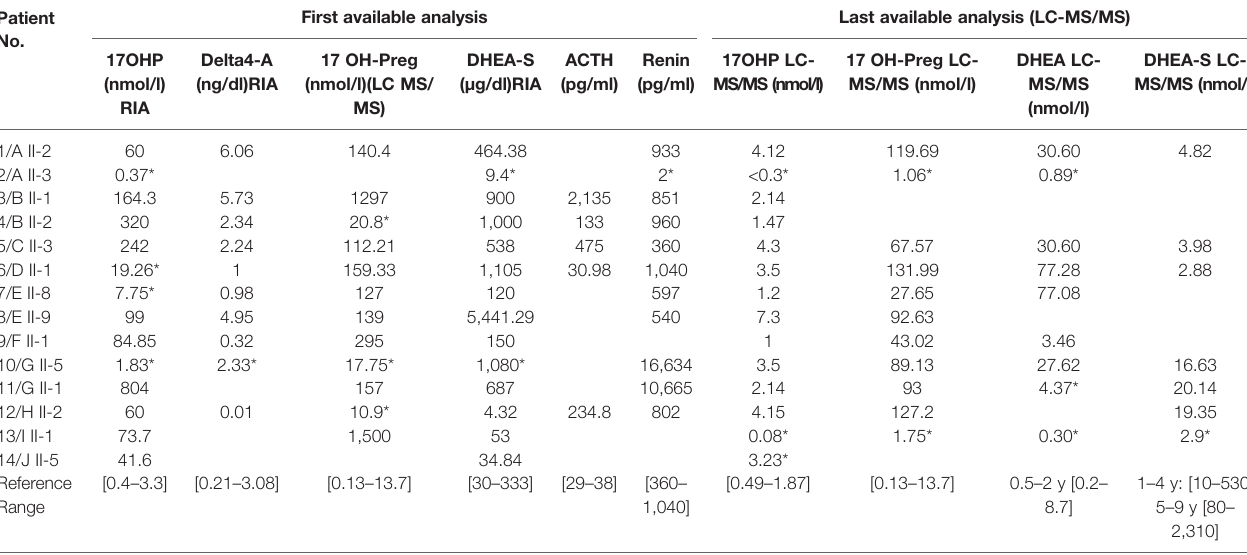
TABLE 2 | Hormonal data in 14 Algerian patients with 3 b -HSD de fi ciency.